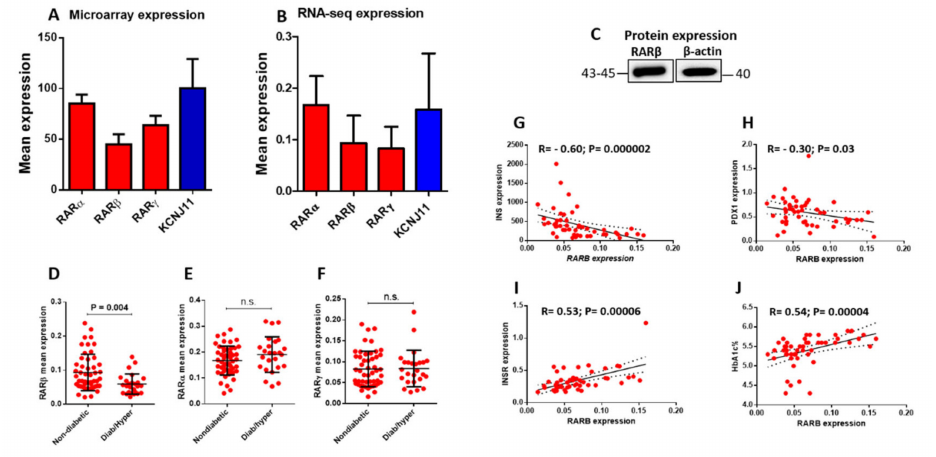
Figure 1. Expression profile of RARs in human pancreatic islets. ( A ) microarray mean gene expression of RAR α , β , γ , and KCNJ11 in nondiabetic/normoglycemic human islets (n. of donors = 45) as determined on Human Gene 1.0 ST array. ( B ) RNA-seq gene expression of RAR α , β , γ , and KCNJ11 in nondiabetic/normoglycemic human islets (n. of donors = 50). ( C ) Western blot expression of RAR β was obtained from non-diabetic human islets ( n = 1; purchased from Prodo Lab. Inc, Maple Plain, MI, USA). Differential expression patterns of RAR β ( D ), RAR α ( E ), and RAR γ ( F ) in nondiabetic/normoglycemic (n. of donors = 50) versus diabetic/hyperglycemic (n. of donors = 25) human islets. Spearman’s expression correlation of RAR β with INS ( G ), PDX1 ( H ), INSR ( I ), and HbA1c levels ( J ) (n. of donors = 50). Expression levels are presented as mean ± SD. Full western blot figures are available in Supplementary